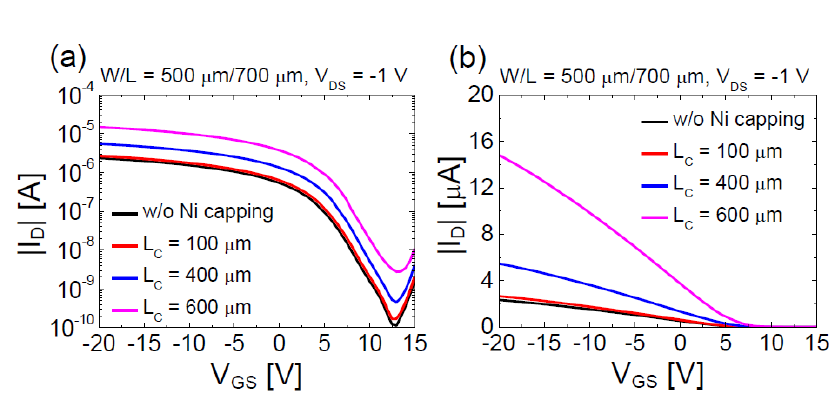
Figure 3. Comparison of ( a ) semi-logarithmic and ( b ) linear scale transfer characteristics of pristine SnO TFT with those of SnO TFTs having different lengths of floating Ni capping layer. Table 1. Electrical parameters measured for the pristine SnO TFT and SnO TFTs with di ff erent L C values. w / o Ni Capping L c = 100 µ m L c = 400 µ m L c = 600 µ